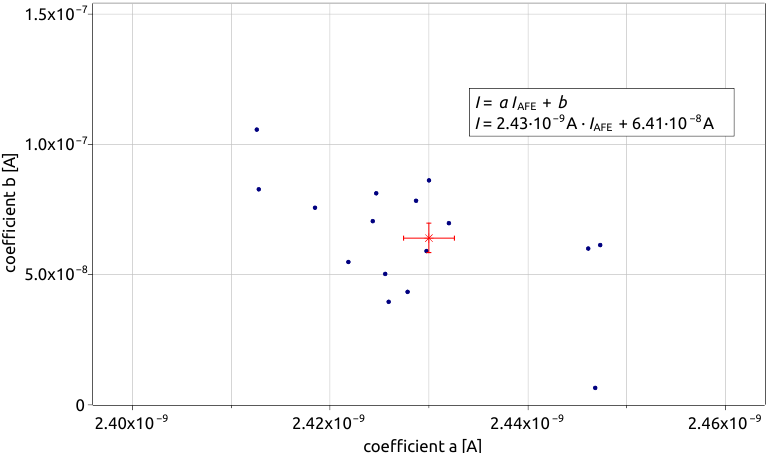
Figure 21. AFE ammeter calibration coefficient distribution. The scale is limited to a narrow range to show small differences in presented values. The average value is marked with a red